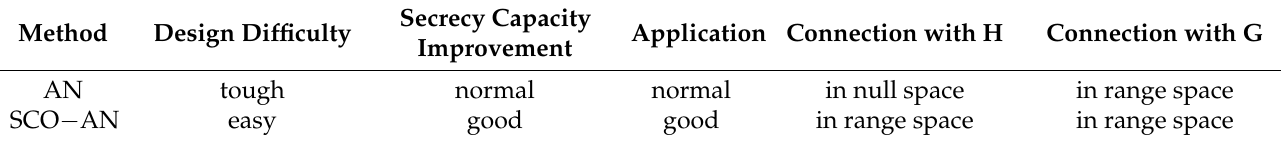
Table 1. Comprison of AN and SCO −